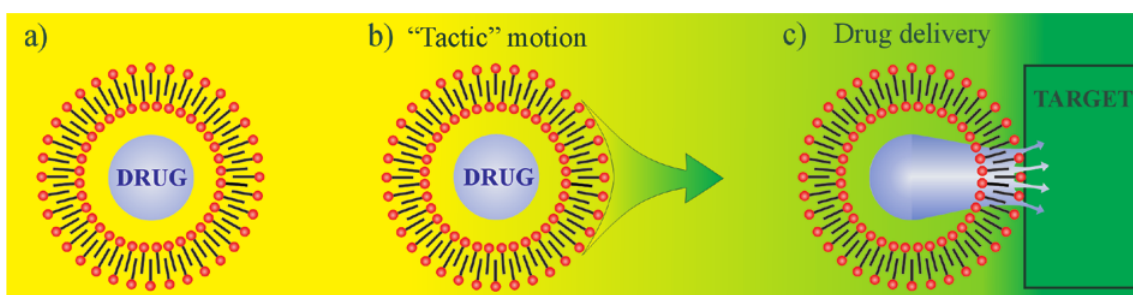
Figure 2. Drug delivery by a chemical robot (artificial tactic